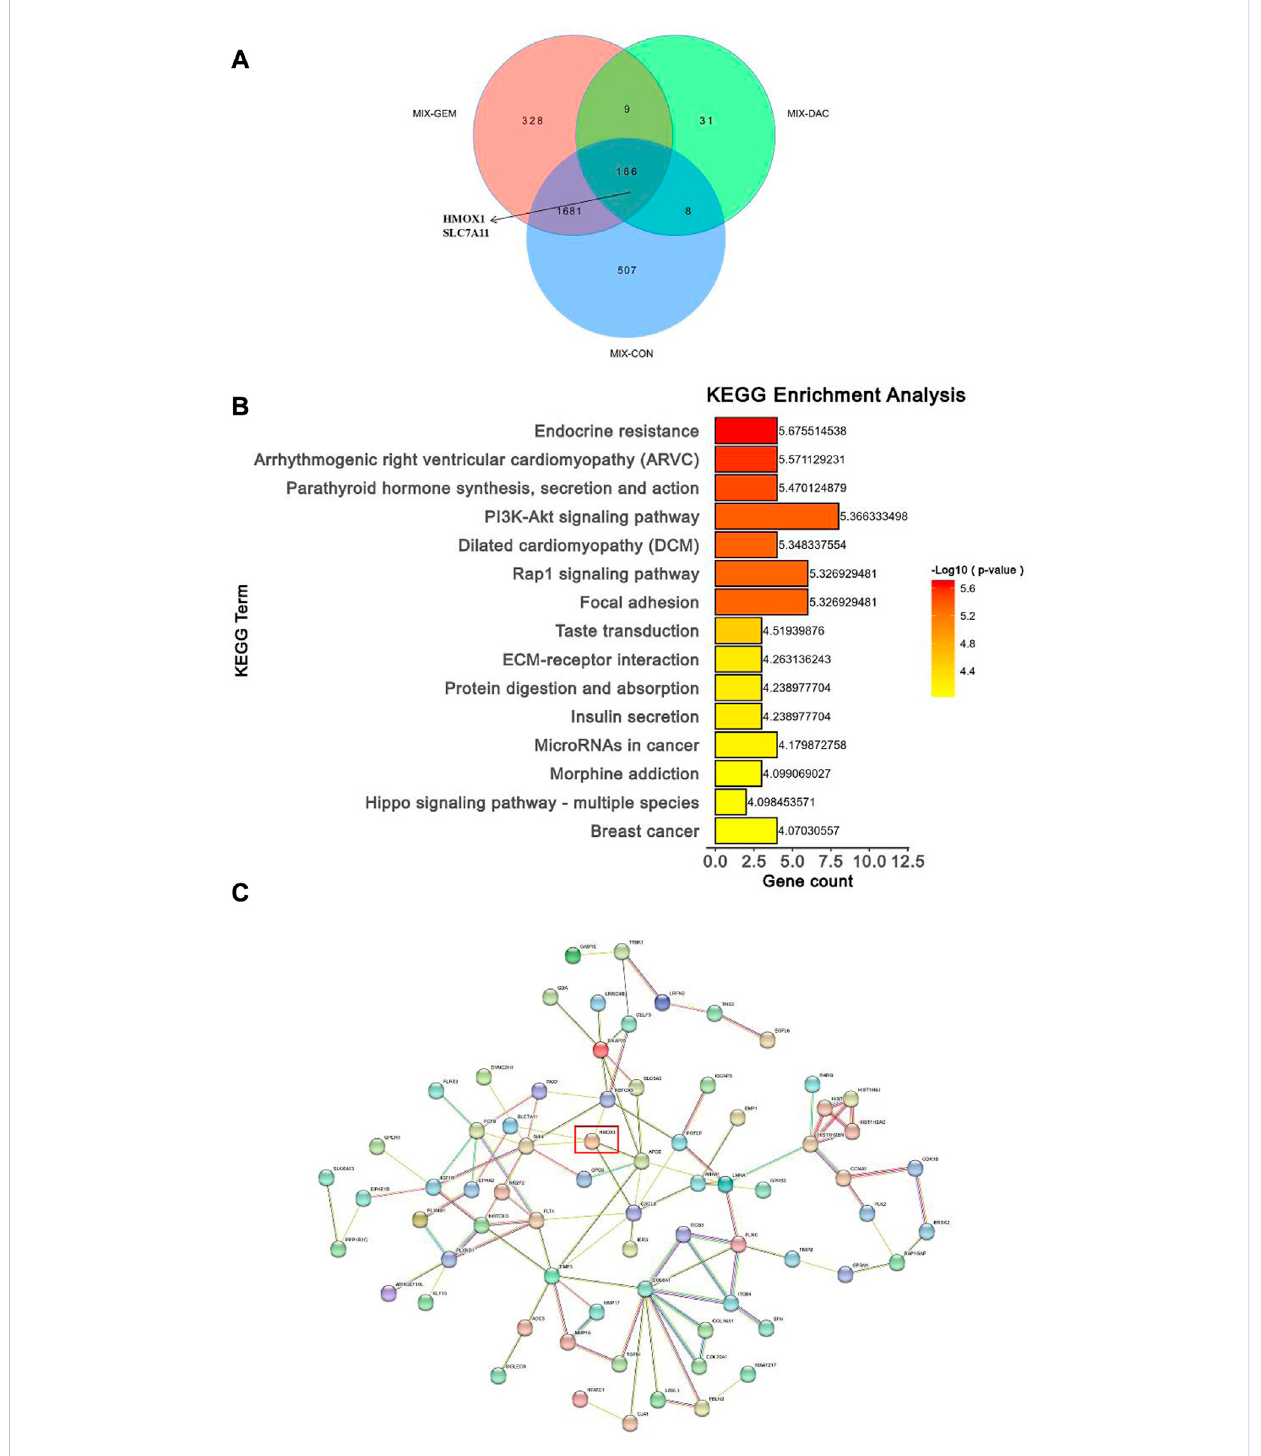
FIGURE 5 Combination of DAC and GEM induced transcriptome level changes. (A) The Venn diagrams showed the DEGs in the combination group when compared with each single drug group and control group in NK92MI cells. (B) The primary signal transduction pathways of DEGs in the combination group compared with each single drug group and control group in NK92MI cells. (C) The protein-protein interaction network topology analysis of DEGs in the combination group compared with each single drug group and control group in NK92MI